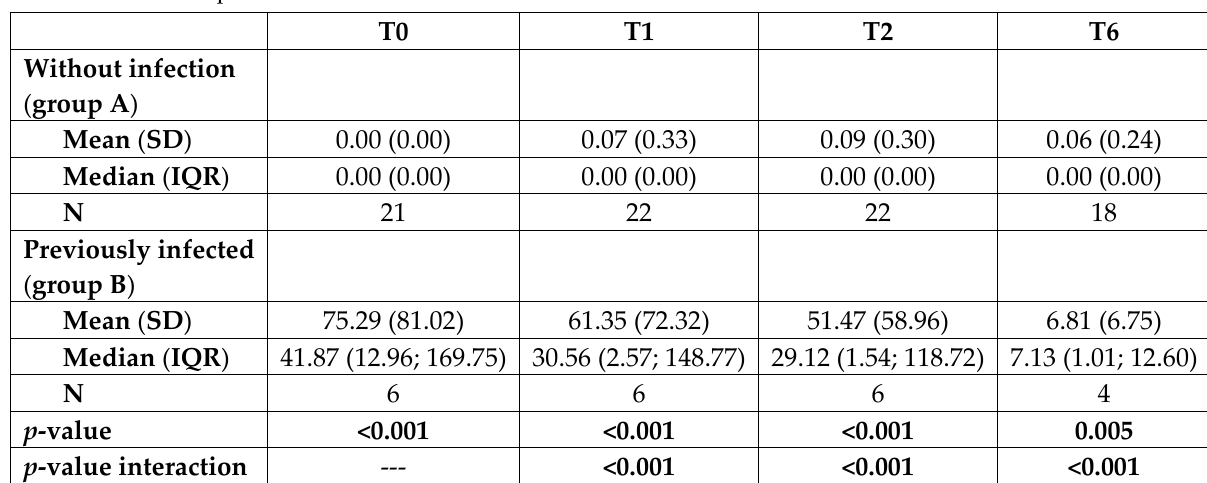
Figure 4. Panel (A): The quantitative antibodies to Spike-1 protein (S AbS) in the two groups of subjects. Panel (B): The quantitative humoral immune response to nucleocapsid protein in the two groups of subjects. The values of quantitative anti-S antibodies (S Abs) are expressed using Binding Antibody Unit (BAU) as mean (standard deviation, SD) and median (interquartile range, IQR). The values of quantitative anti-N antibodies (N Abs) are expressed using COI (cutoff index). p -value between the two groups is analyzed at each timepoint with Mann–Whitney test.